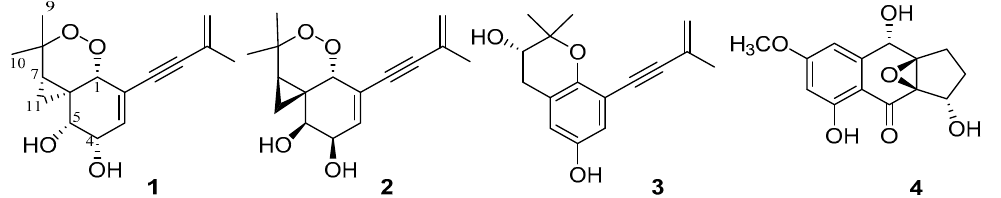
Figure 5. Structures of 1 − 4 from MeHatOE.